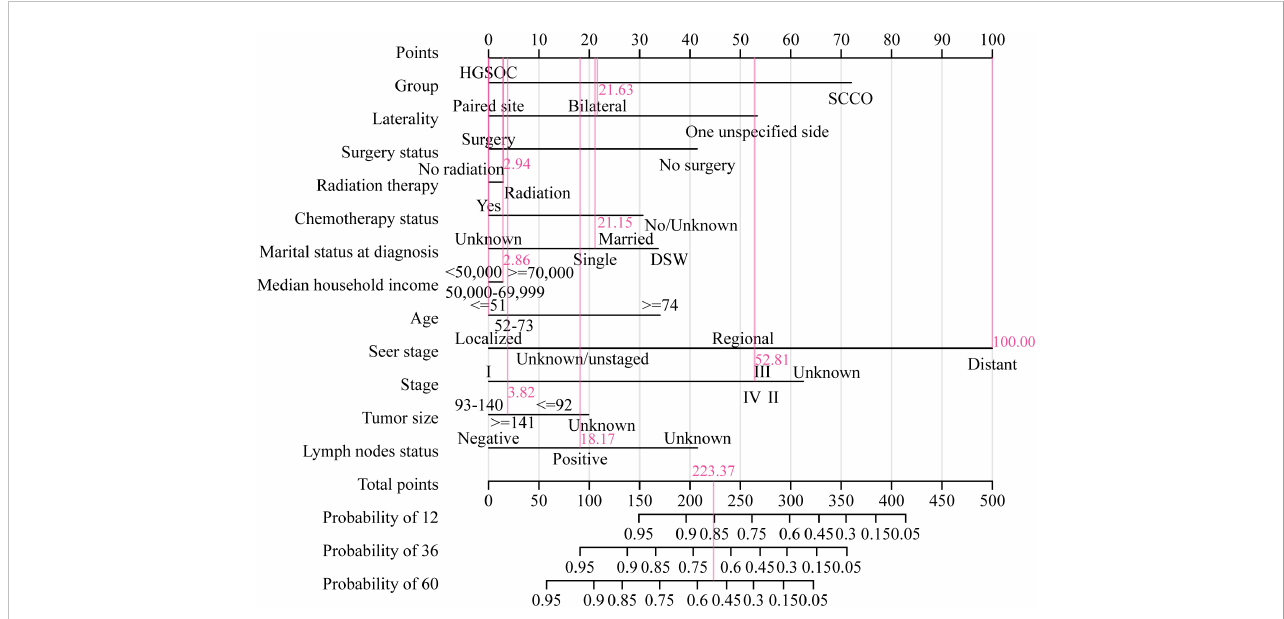
FIGURE 7 The nomogram of CSS associated predictive models. The sum of the scores represented by the pink arrows represents the survival probability corresponding to 1, 3, and 5